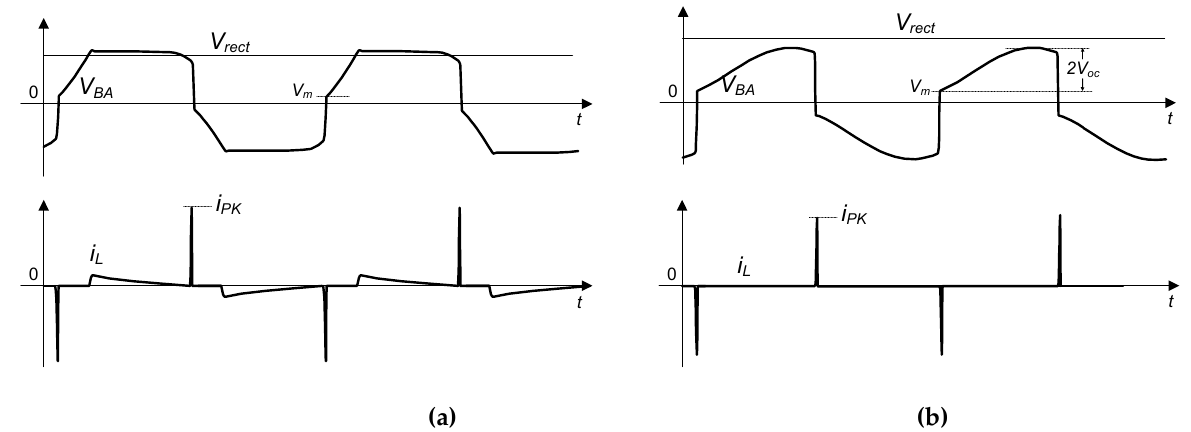
Figure 6. Waveform of the PE voltage V BA and inductor current i L ( a ) in the P-SSHI mode, and ( b ) in the S-SSHI mode.